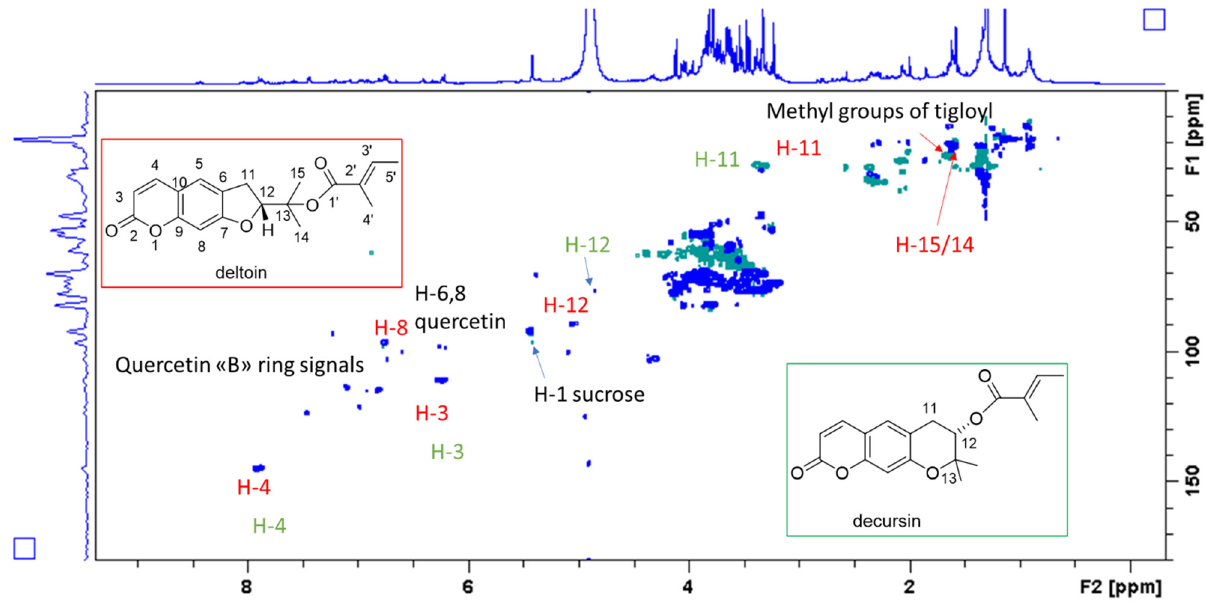
Figure 2. HSQC-DEPT spectrum of methanol extract from Sartoria aerial part. Structures of the two main constituents, namely deltoin and decursin, are highlighted. Main assignments are also indicated with red and green colors, respectively.